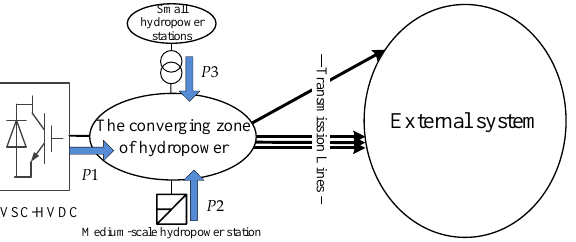
Figure 4. Schematic diagram of a practical transmission system with VSC-HVDC.